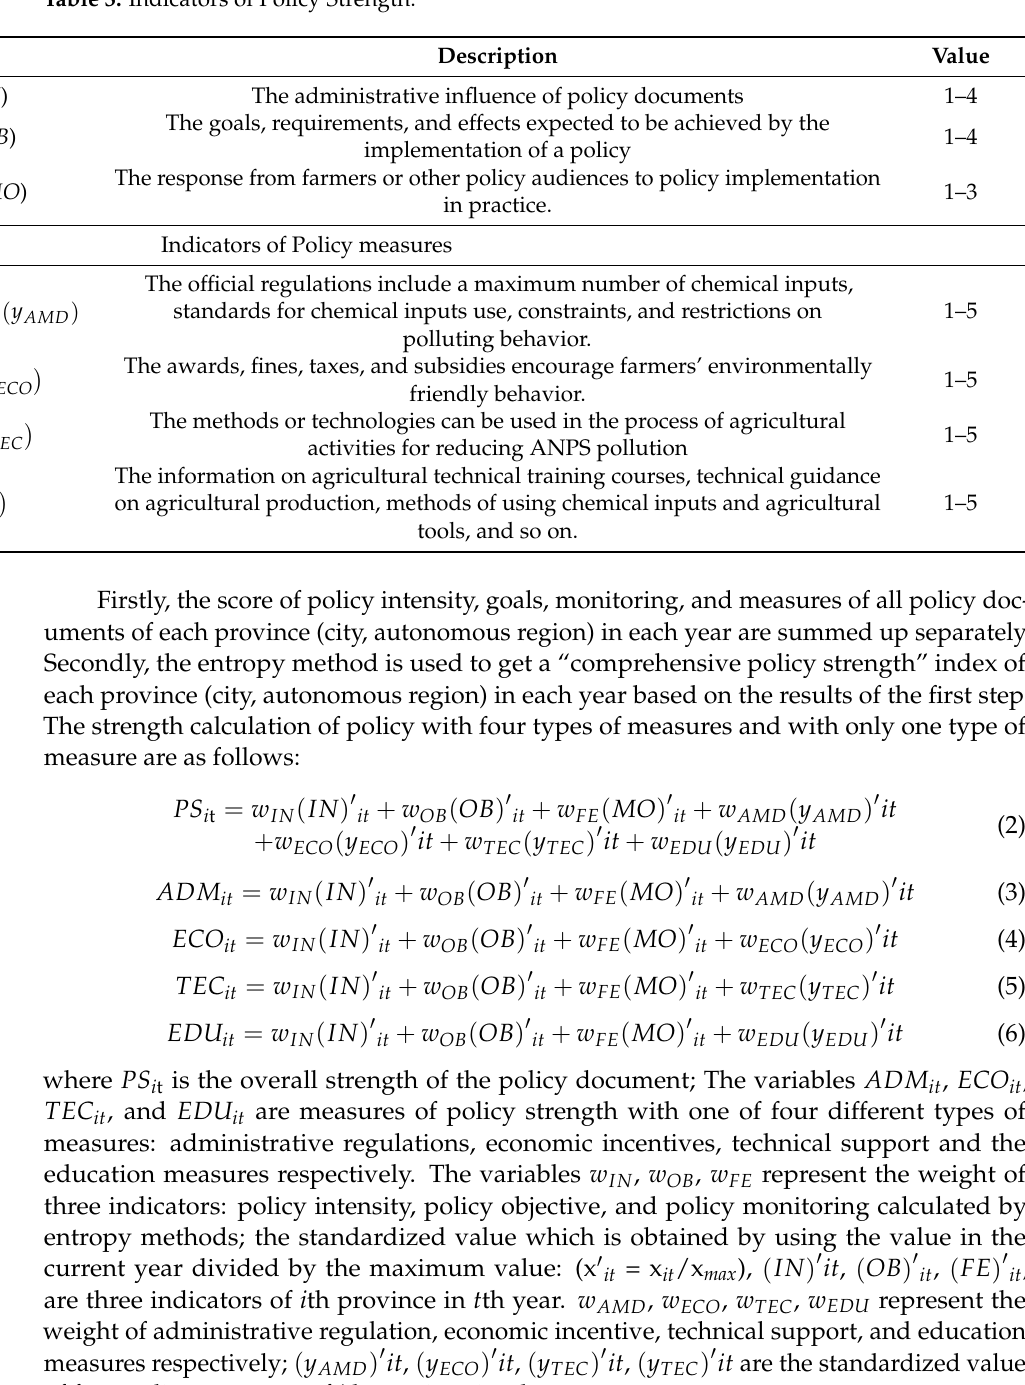
Table 3. Indicators of Policy